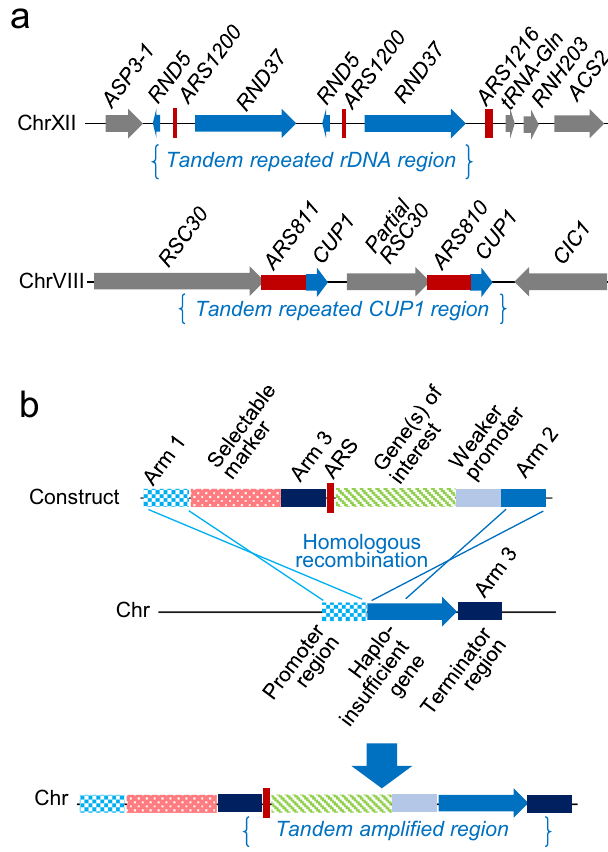
Fig. 1 Design of in vivo gene ampli fi cation. a Natural genome structures at the ribosomal DNA (rDNA) locus on chromosome XII and the CUP1 locus on chromosome VII. b Construct design for in vivo gene ampli fi cation (HapAmp). ARS autonomous replicating